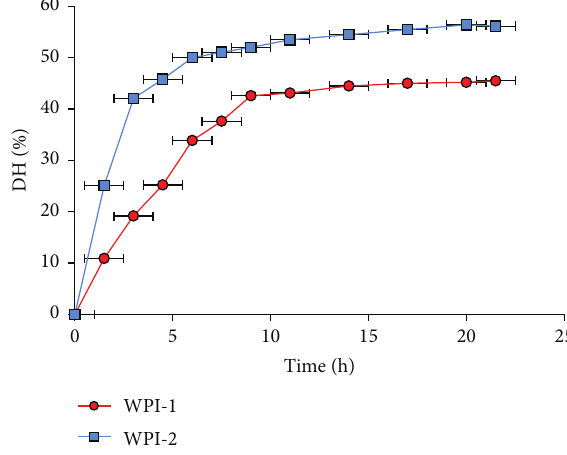
Figure 2: %DH from WPC-1 and WPC-2 with biomass from B. subtilis